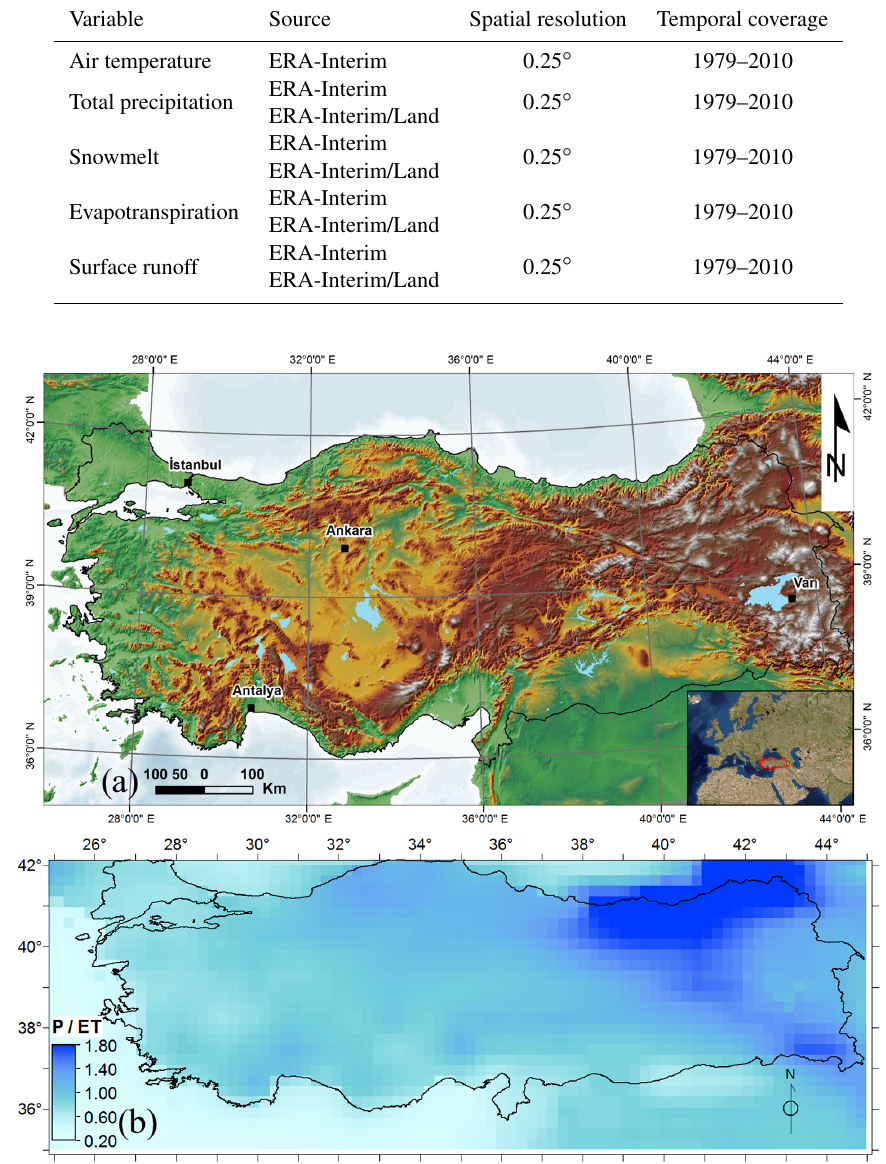
Figure 1. (a) The geographic location and the topography of the study area and (b) the distribution of the average of the precipitation to evapotranspiration ratio as estimated from the ERA-Interim/Land dataset for the 1979–2010